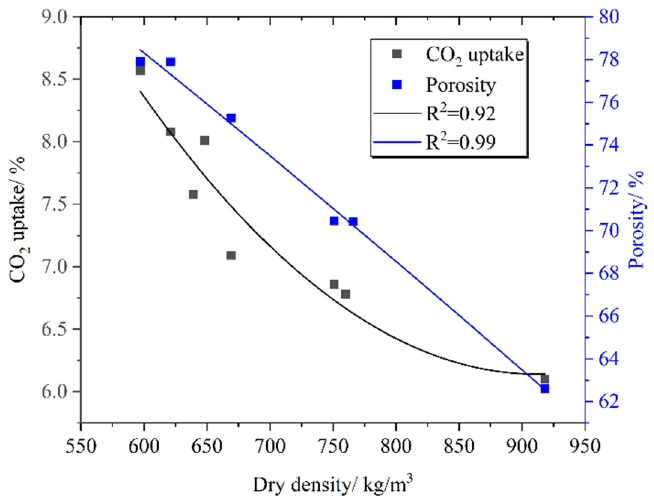
Figure 8. Relationship of CO 2 uptake and porosity to dry density.